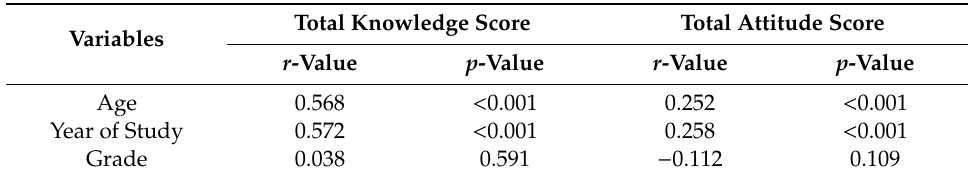
Table 6. Association between total knowledge and attitude scores with age, year of study, and examination grade using the Pearson correlation test ( n = 204).